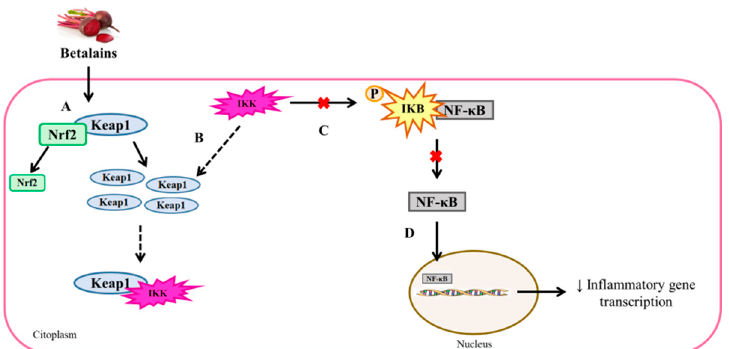
Figure 5. Anti-inflammatory effects of betanins through the modulation of Nrf2-Keap1 and NF- κ B- IKB complex dissociation. IKB: KB inhibitor, IKK: ikB kinase, Keap1: Kelch-like repressor protein ECH-associated protein 1, NF- κ B: nuclear factor κ B and Nrf2: nuclear factor erythroid 2-related factor 2.